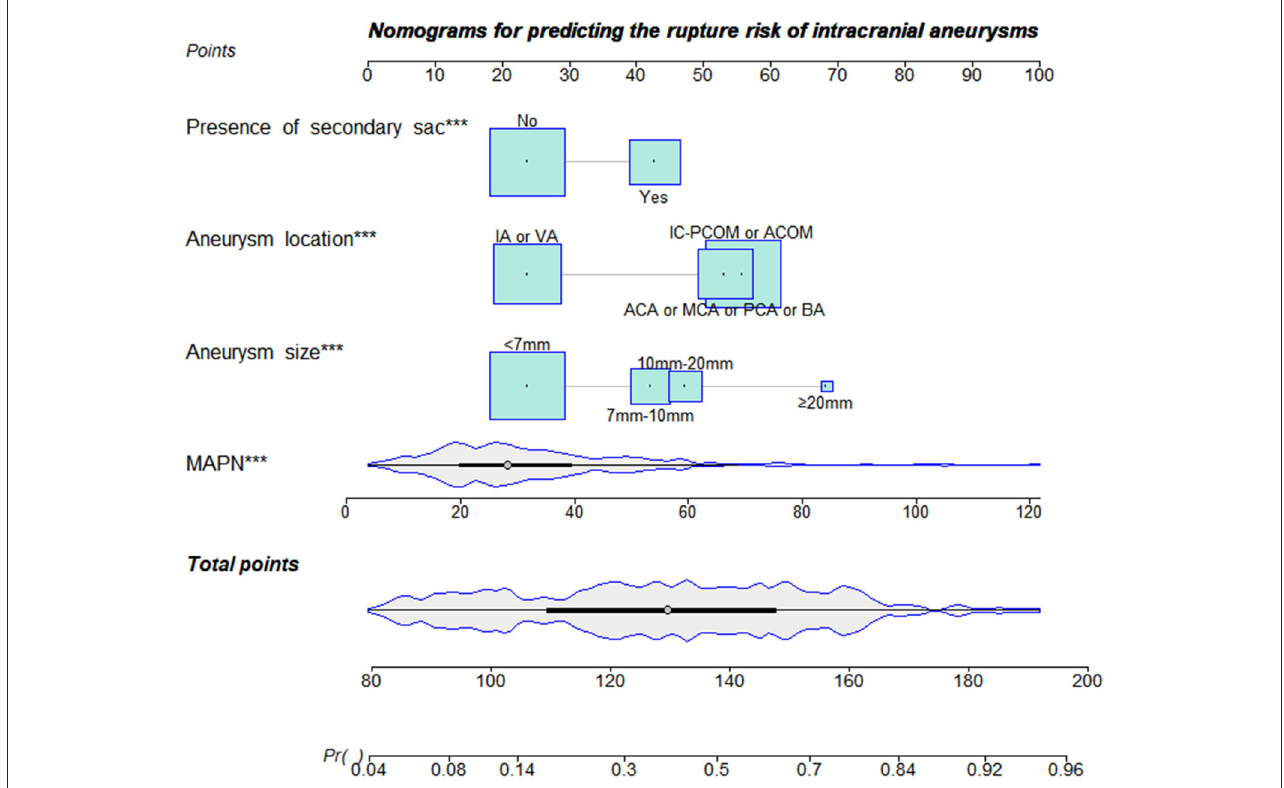
FIGURE4 The nomogram was plotted based on 4 independent factors. The size of the bars indicates the number for each category, and the density plot represents the population distribution of each continuous variable. The total points, derived from the sum points of the four individual indexes, determined the risk of aneurysm